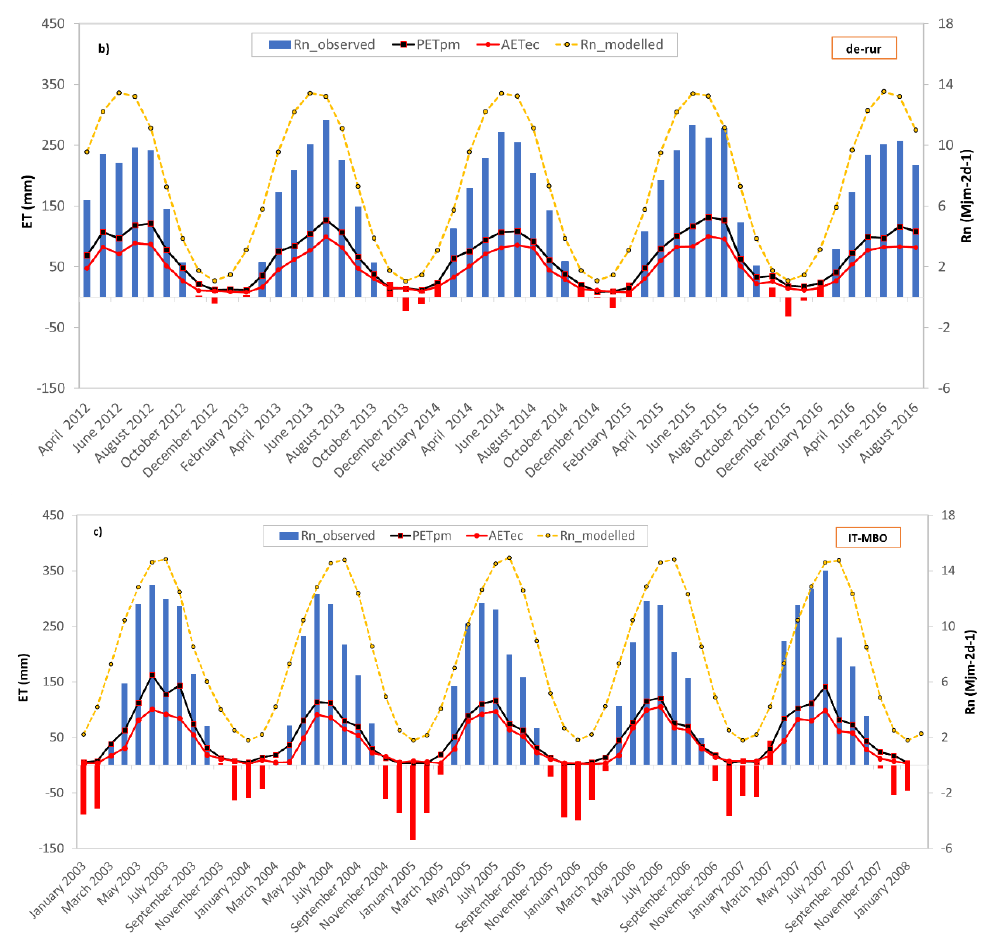
Figure 6. Monthly actual evapotranspiration, Penman potential evapotranspiration and observed and modelled net radiation at Sister site ( a ), Rollesbroich site ( b ) and Bondone mountain ( c ) for the period under investigation. Red bars indicate net radiation values below the net radiation threshold.